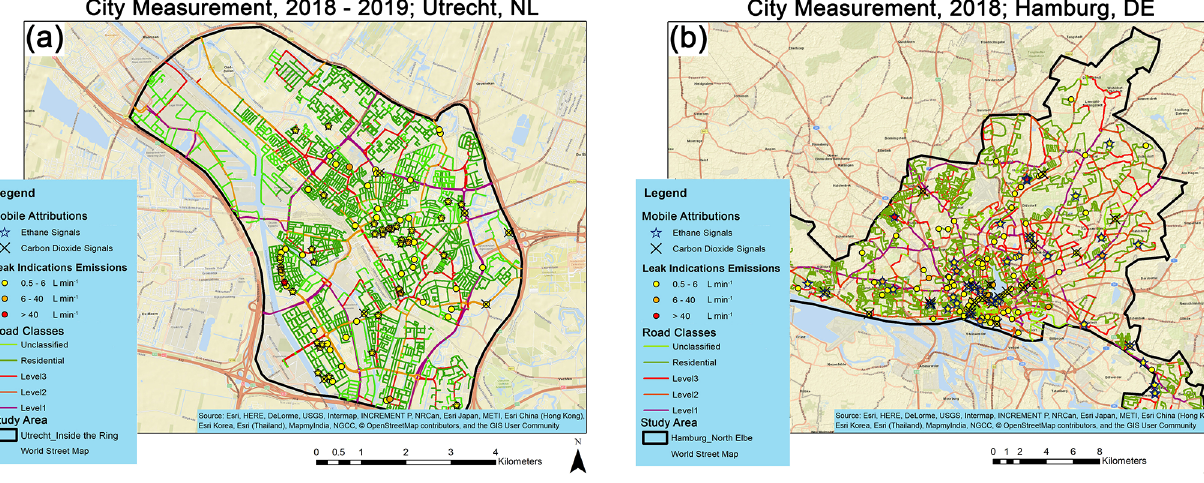
Figure 1. Locations of significant LIs for the categories on different street classes in (a) Utrecht and (b) Hamburg. Road colors indicate the street classes according to the OSM. Black polygons show urban study